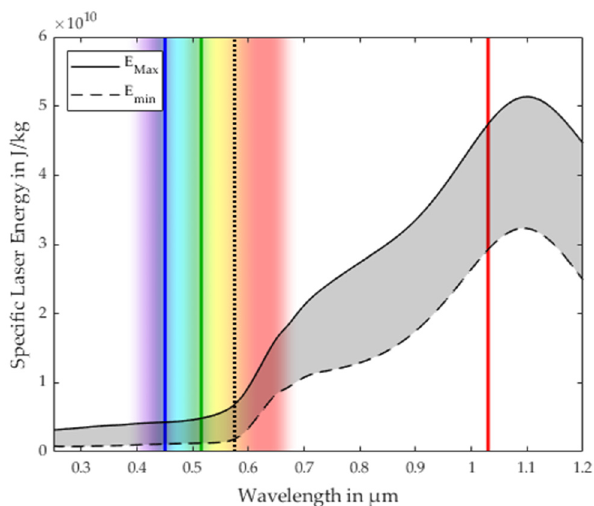
a guide to the eye. The vertical black dash-dotted line indicates the X-point at ~575 nm. For the data of solid copper, the measurement accuracy is not explicitly given in the source.